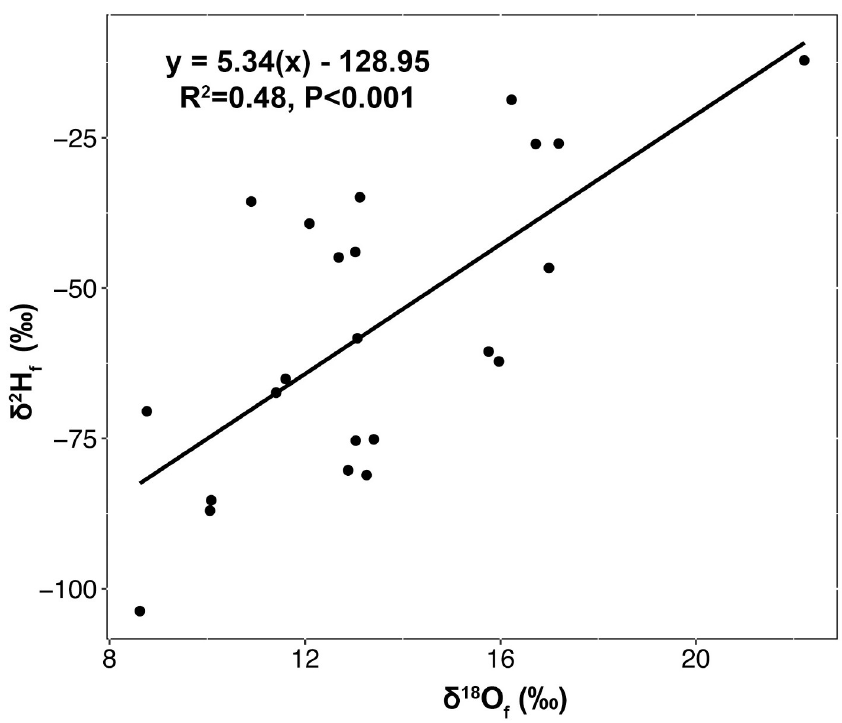
Fig 2. Relationship between the stable isotope composition of museum specimens of Sharp-shinned Hawks ( Accipiter striatus ). Stable hydrogen ( δ 2 H F ‰) and oxygen ( δ 18 O F ‰) isotope values for juvenile museum feather specimens ( n = 23) of known natal origin.